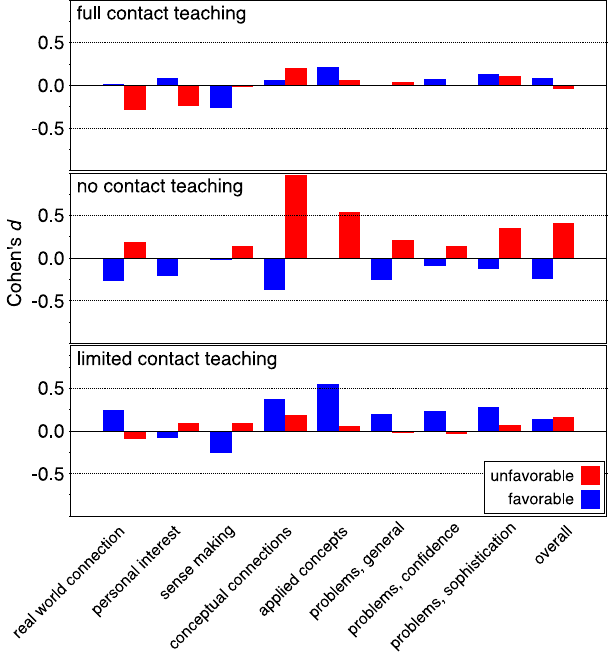
FIG. 2. Effect size from presurvey to postsurvey for different levels of contact